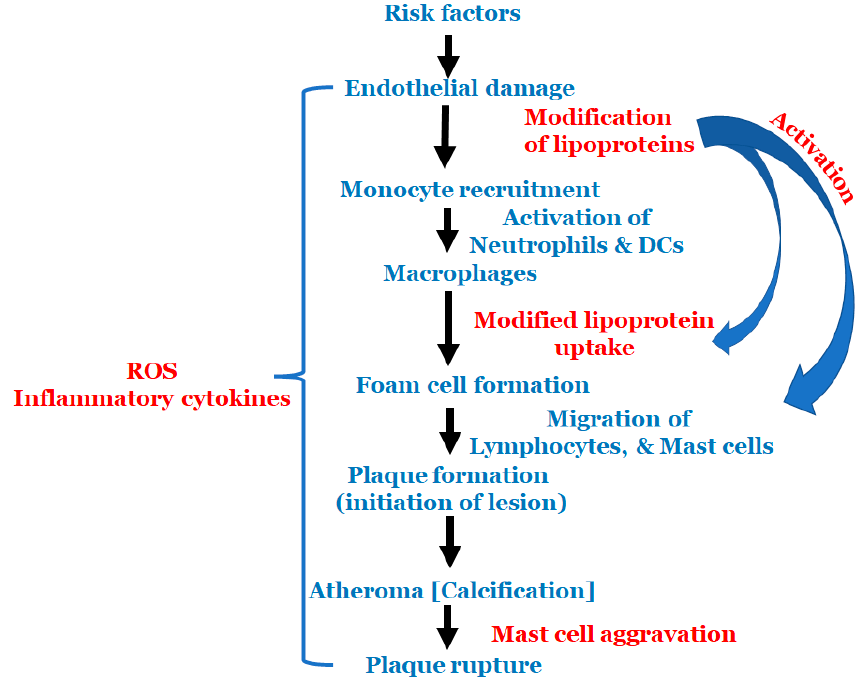
Figure 2. Schematic representation of the events in atherosclerosis.